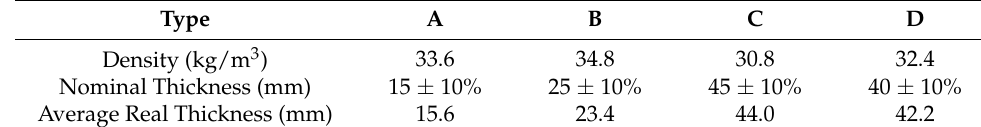
Table 2. Characterization of non-woven type sheep wool thermal-insulating mattresses.